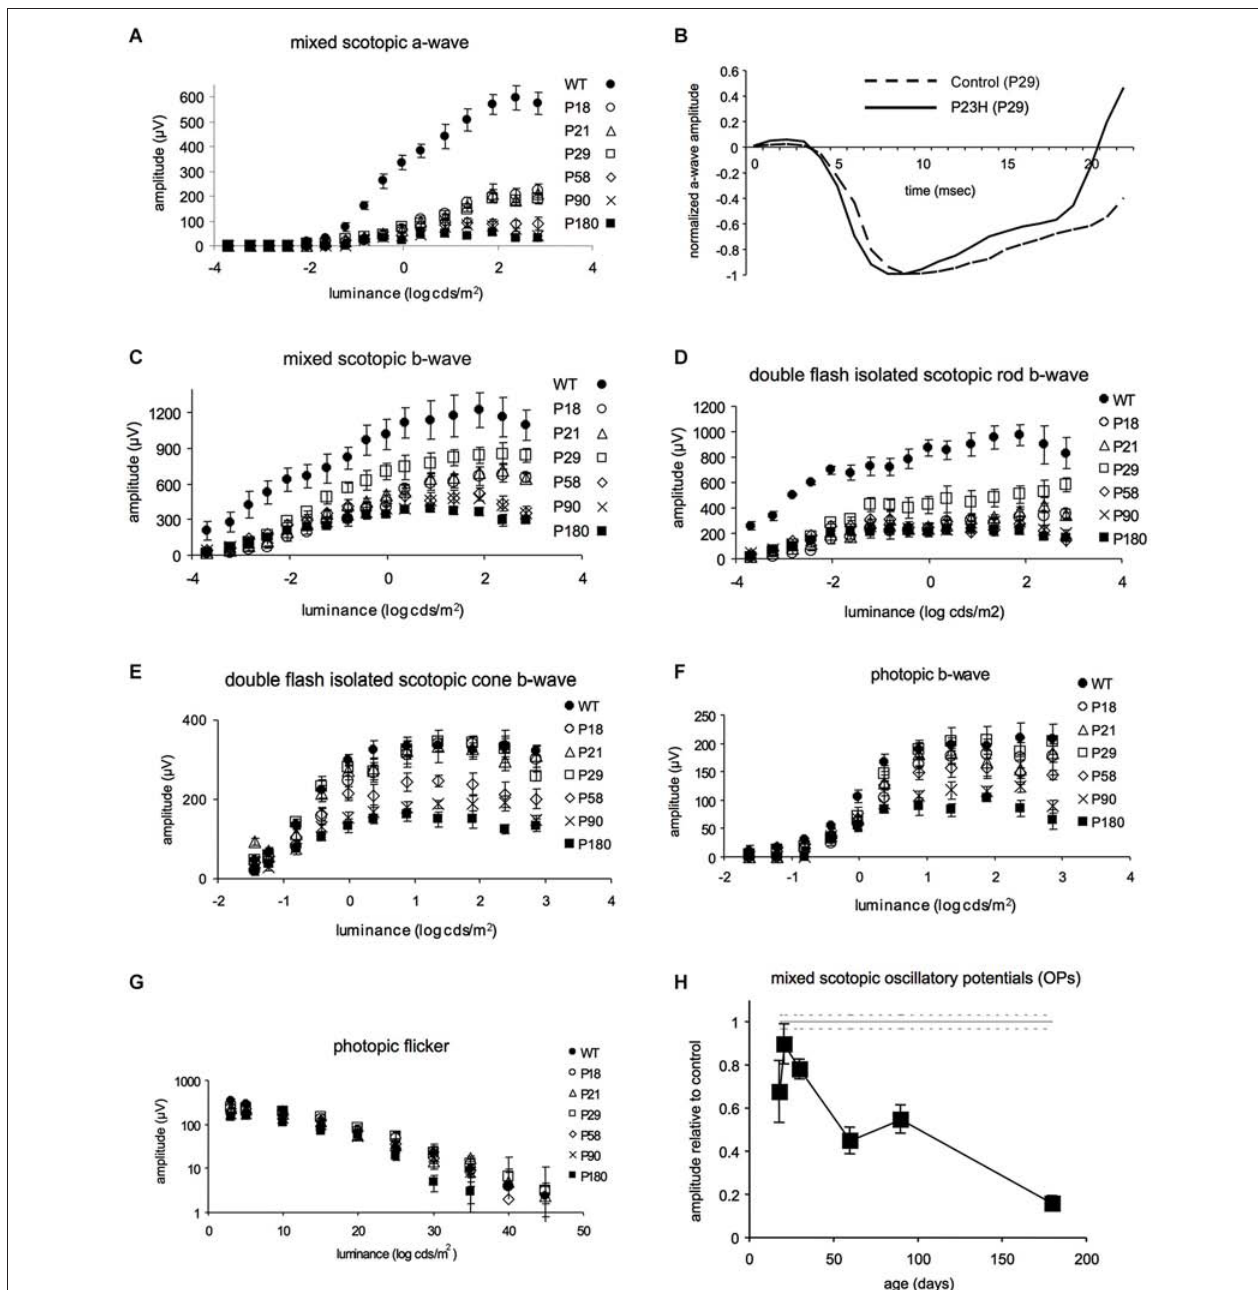
FIGURE 2 | Functional comparison by ERG between pigmented P23H L-1 and control rats. (A) ERG amplitude vs. flash intensity (V-log I) series of mixed scotopic a-waves from LExSD and P23H rats. (B) Example of a-waves recorded at age P29 in normal (dotted line) and P23H (continuous line) rats. Amplitude values are normalized with respect to the maximal amplitudes; absolute amplitudes were 540 µ V and 159 µ V in normal rats and P23H rats, respectively. Stimulus luminance: 0.38 log cds/m 2 . (C, D) ERG amplitude vs. flash intensity (V-log I) series of mixed scotopic b-waves (panel C ) and double flash isolated scotopic rod b-waves (panel D ) Amplitudes increased from P18 to P29 in P23H rats and subsequently decreased in P23H rats with increasing age. (E, F) ERG amplitude